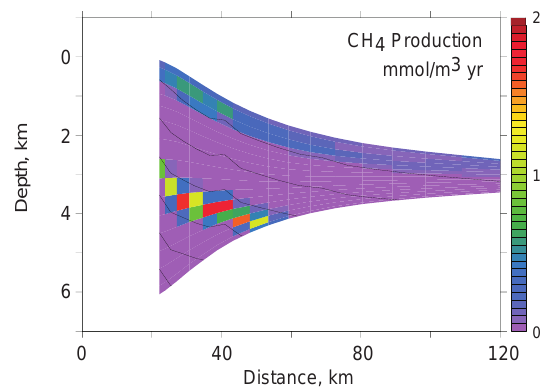
Fig. 8. Methanogenesis rates in the Base scenario. Shallow is from biological activity: deep is thermogenic methane production rates. Contours are temperature. Results from other scenarios are shown in the Supplement files CH 4 src a.pdf and CH 4 src b.pdf, and an animation can be seen at http://geosci.uchicago.edu/ ∼ archer/ spongebob active/ch4